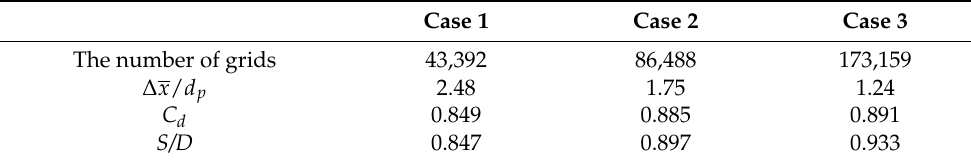
Table 6. Grid sensitivity result.